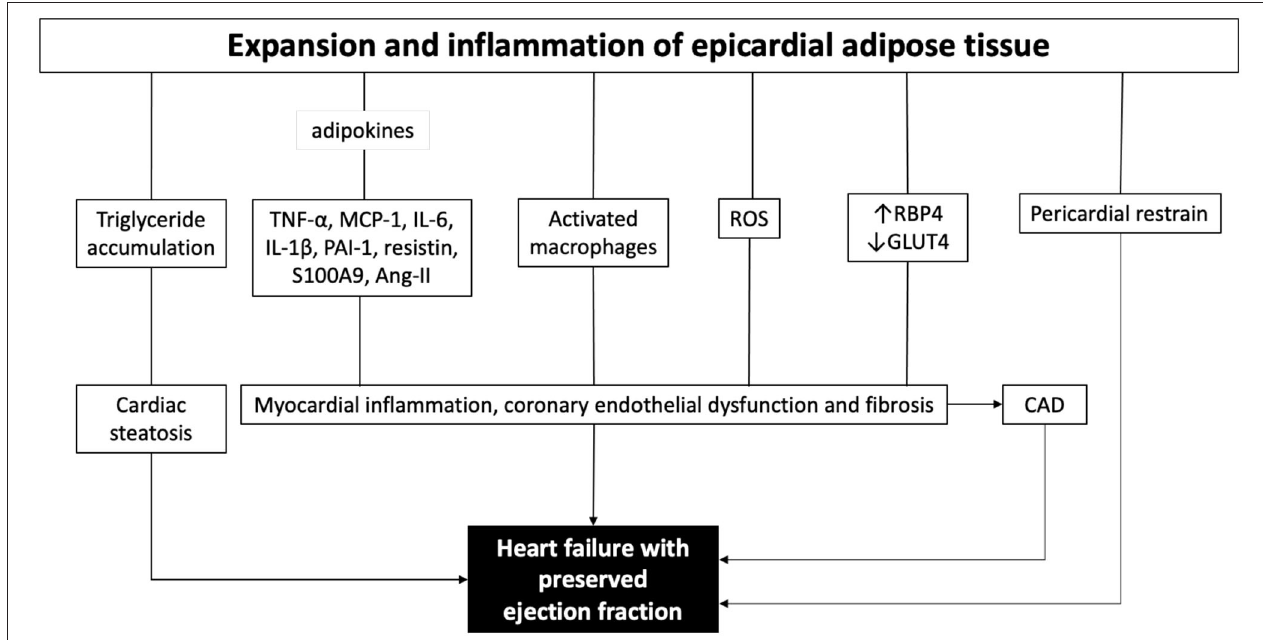
FIGURE 1 | The role of epicardial adipose tissue in the pathogenesis of heart failure with preserved ejection fraction. ROS, reactive oxygen species; TNF- α , tumor necrosis factor alpha; MCP-1, monocyte chemoattractant protein 1; IL-6, interleukin 6; IL-1b, interleukin 1b; PAI-1, plasminogen activator inhibitor-1; Ang-II, angiotensin II; ROS, reactive oxygen species; RBP4, renitol-binding protein 4; GLUT4, glucose transporter-4; CAD, coronary artery disease.